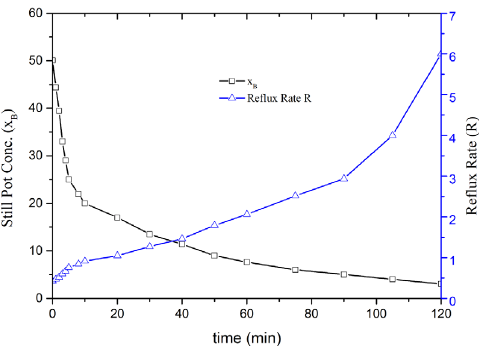
Fig. 6. Bottom concentration vs . variable re fl ux that maintains constant distillate concentration at 0.90.